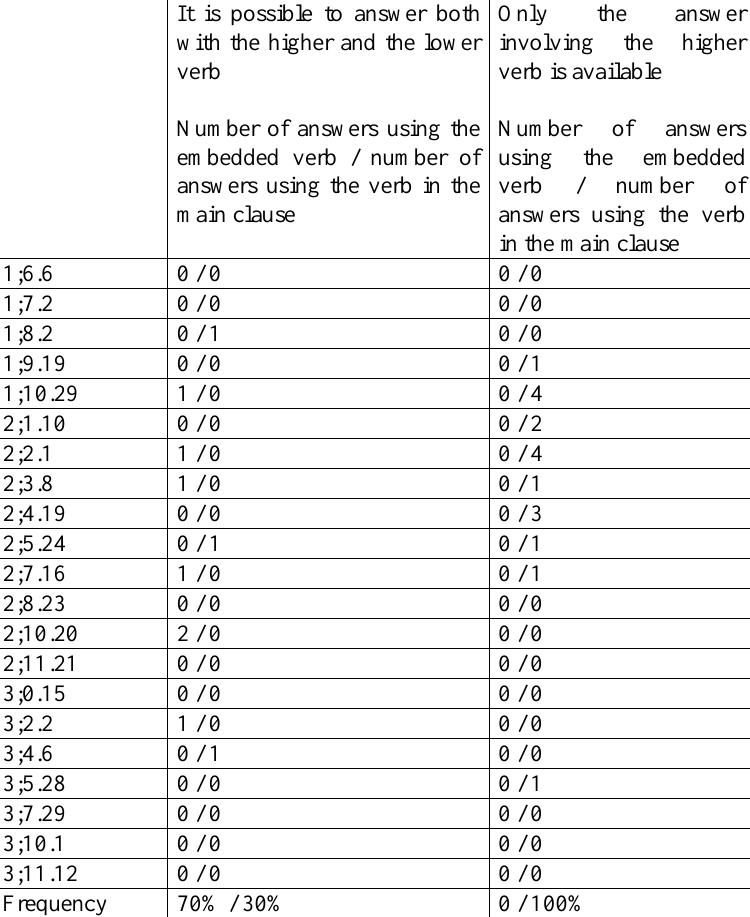
Table VII. Verbal answers / confirmations of questions / declarative sentences presenting embedding in Inês’